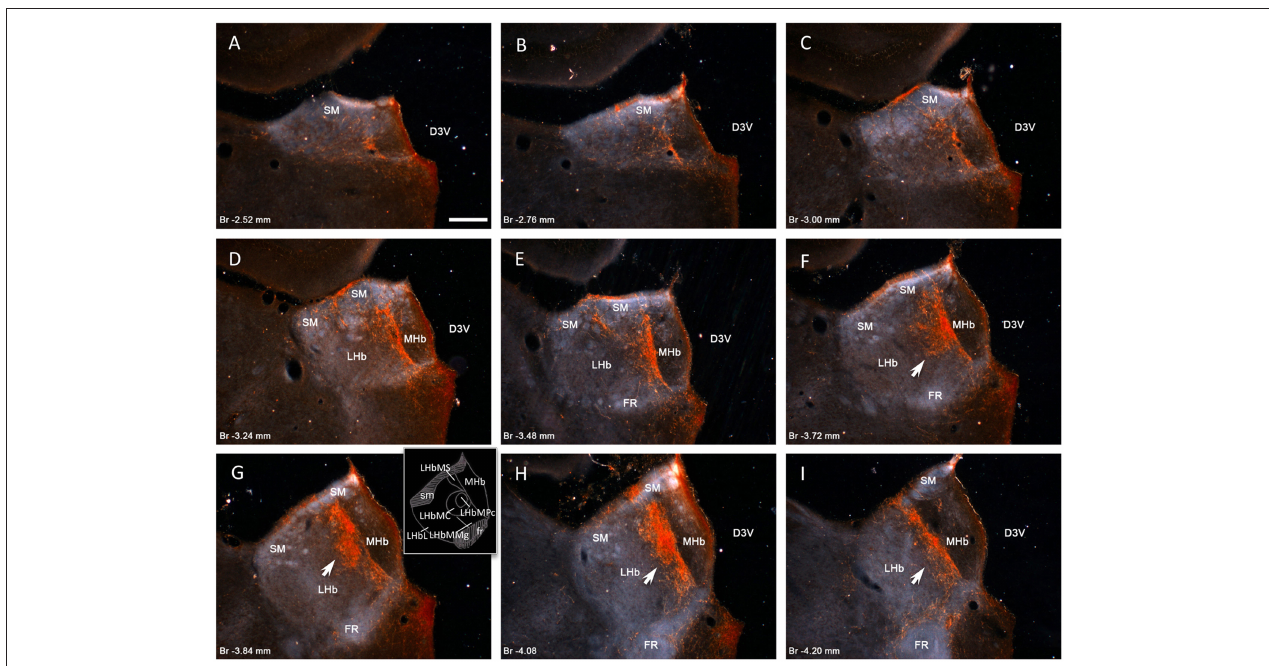
FIGURE 1 | Vasopressin immunopositive fiber distribution through the rostro-caudal extent of rat habenular complex. Panels (A–I) dark-field photomicrographs of AVP immunoreaction on coronal sections at the rostro-caudal Bregma levels indicated in each panel. Vasopressin immunopositive fibers densely innervate the medial division of lateral habenular complex (LHbM), i.e., the superior subnucleus (LHbMS), the central subnucleus (LHbMC), remarkably its parvocellular subnucleus (LHbMPc), and the marginal subnucleus (LHbMMg). Inset of the panel (G) shows a drawing with the subnuclei mentioned. Note that highest density of AVP+ fibers is observed inside the LHbMC (panels F–H arrows). Scale bars: 250 µ m. D3V, dorsal 3rd ventricle; MHb, medial habenular complex; LHb, lateral habenular complex; SM, stria medularis; FR, fasciculus